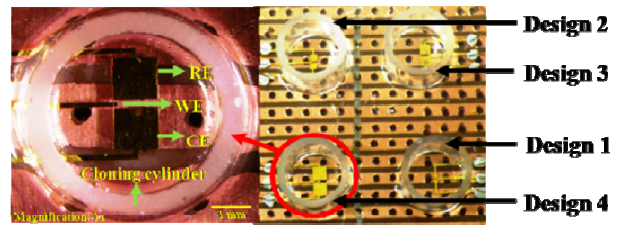
Fig. 2: Microphotograph of different three-electrode devices. Inset is the enlarged view of Design